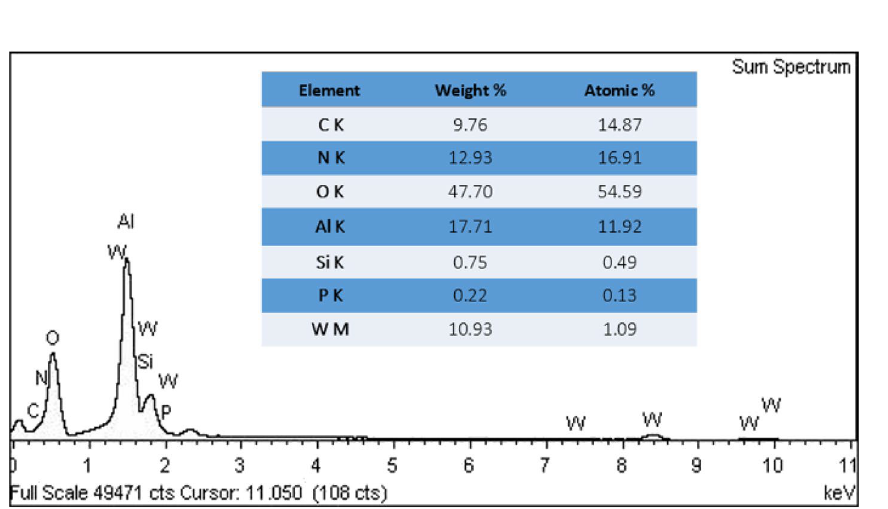
Figure 3. EDS analysis of